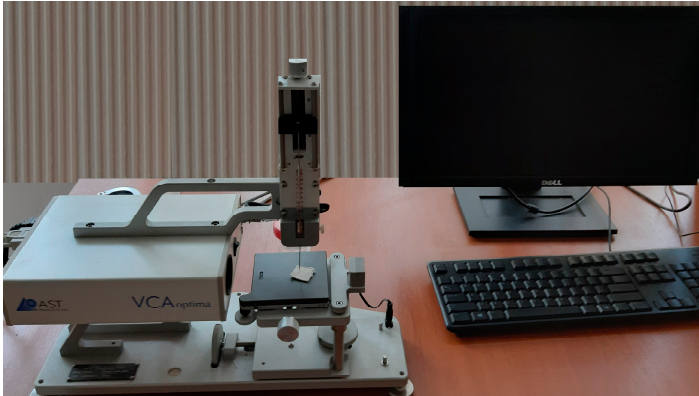
Figure 2. VCA Optima device for contact angle investigation (AST products). The surface resistances were evaluated using two devices: 1.